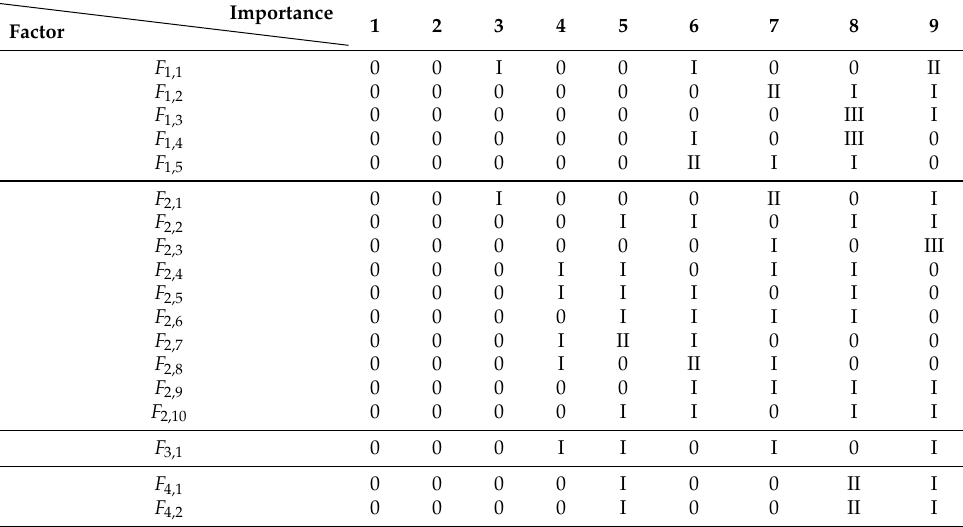
Table A2. The overall results for factors from all